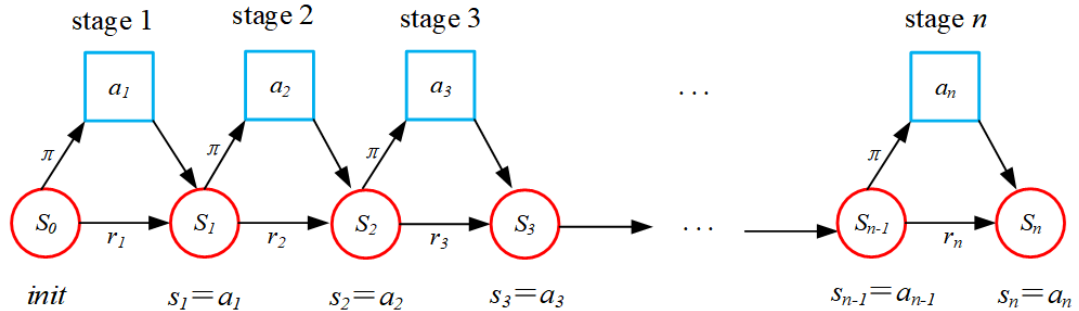
Figure 5. Markov decision-making process for the n -stage packing.